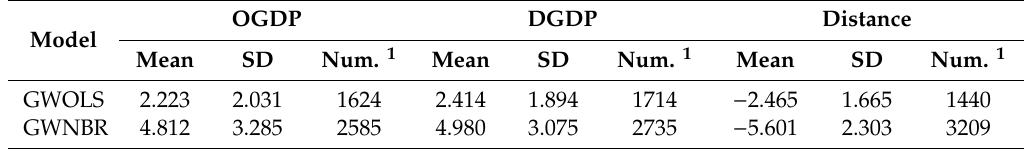
Table 1. Comparison in t-statistics distribution from local OLS and